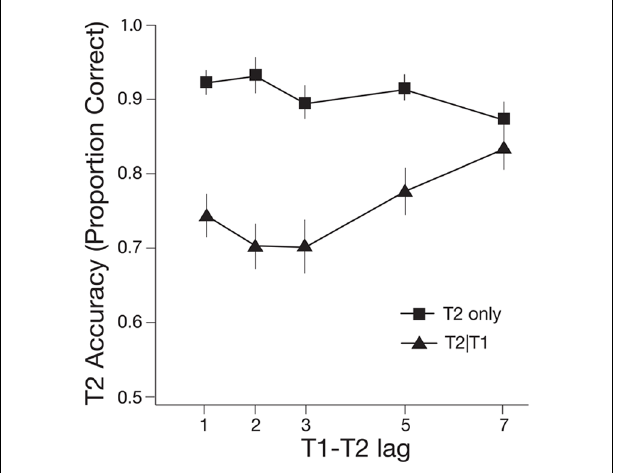
FIGURE 3 | Mean accuracy ofT2|T1 identification for the congruent, incongruent, and irrelevant odor conditions of Experiment 1, plotted as a function ofT1–T2 lag. Mean accuracy for identifyingT2 only is also shown, pooled across the three odor conditions. One lag corresponds with 66.6 ms. Error bars represent one standard error of the mean. * p <